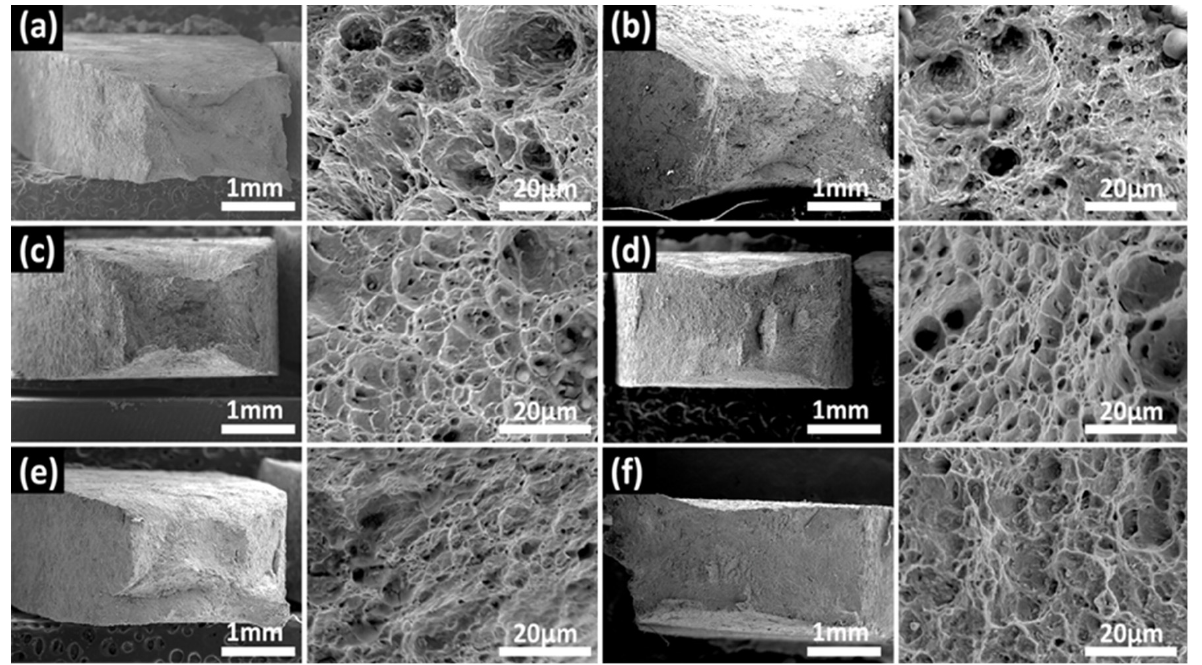
Figure 10. Fracture morphologies for X80 under different CP potentials ranging from OCP to − 1200